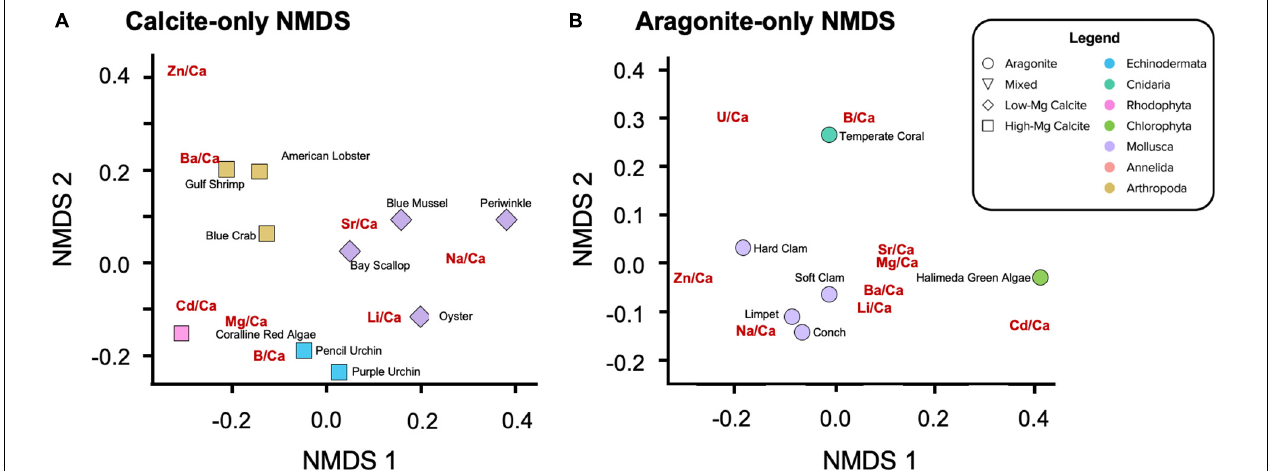
FIGURE 6 | NMDS ordination of elemental ratios for (A) calcitic and (B) aragonitic organisms only, which are separated by species. The elemental ratios themselves are also represented in the ordination space. The positioning of the elemental ratios depends on the apparent level of incorporation in the respective biogenic carbonates; the closer to an organism the trace element ratio, the higher the level of incorporation of that element relative to the other organisms represented in the space. Considering only one mineralogy at a times excludes the influence of mineralogical differences. The color of a point denotes phyla. (A) Similar to Figure 4B , PERMANOVA determines significant clustering of points by phylum ( p = 0.003). The stress value for this analysis is 0.035. (B) Similar to Figure 4B , PERMANOVA determines significant clustering of points by phylum ( p = 0.136). The stress value for this analysis is